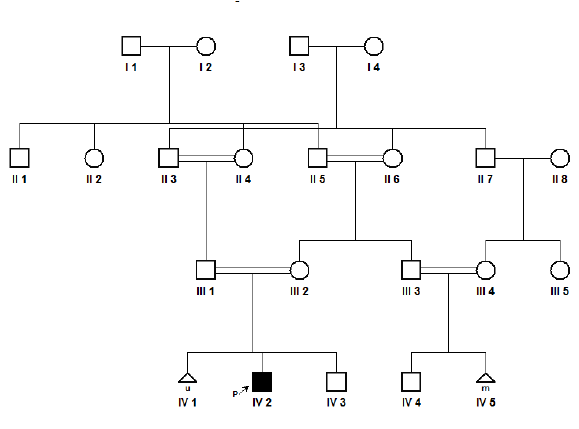
Figure 1. A Pedigree of a Consanguineous Family Representing MCPH2. Note . MCPH2: Autosomal recessive primary